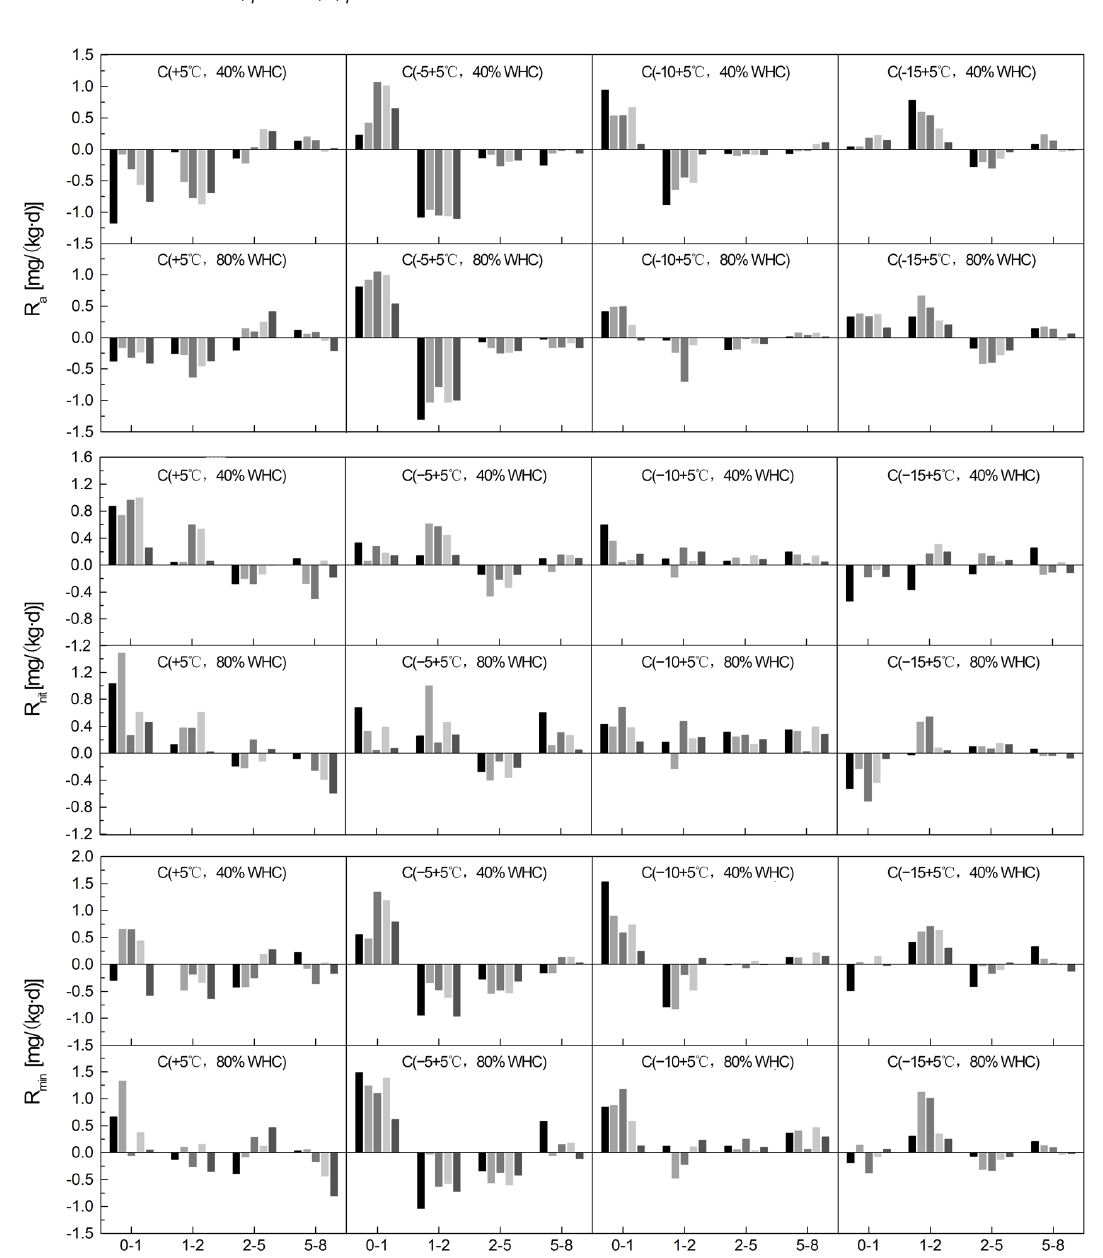
Figure 6. Soil N mineralization and nitrification rates under different soil salt contents (SSC), freezing–thawing (FT) temperatures/cycles, and soil water contents (SWC).